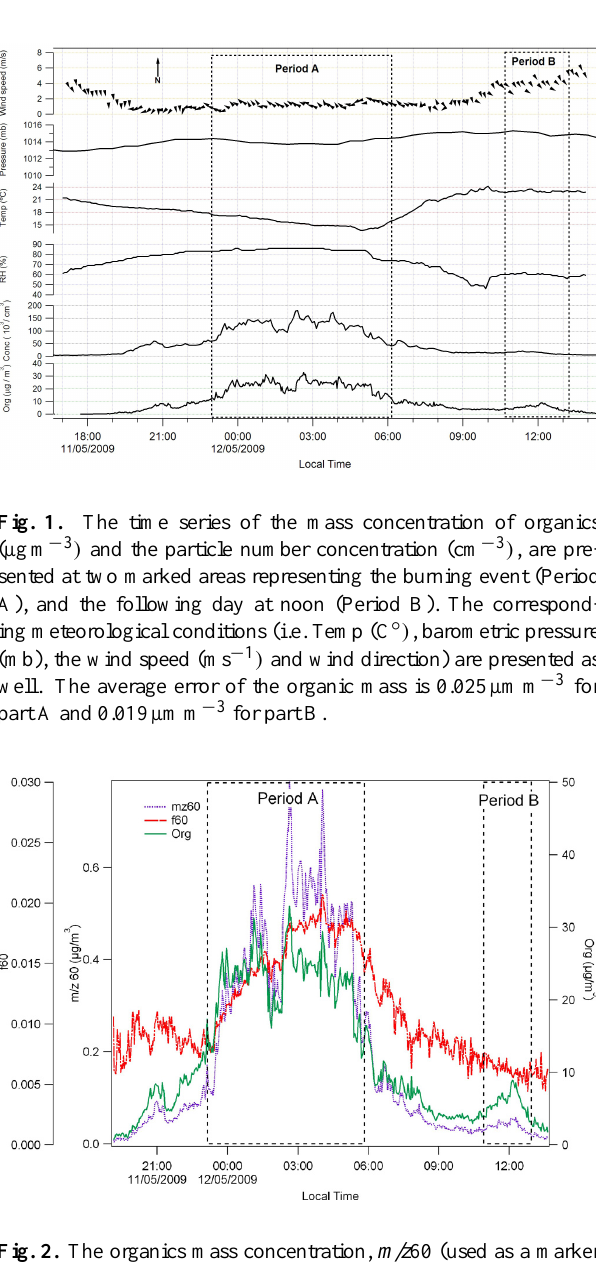
Fig. 10. The organics mass, the total concentration of the SMPS (# cm -­‐3 ) and ozone concentration (ppb) plotted as a function of local time, during the burning event (period A) and the following day (period B). Fig. 11. The SMPS size distributions normalized to the maximum concentration, the organics and f44 are presented as a function of time. Fig. 12. Time series of the Real and imaginary components of the effective broadband refractive index (EBRI). The total organic mass is plotted to serve as a reference point. The